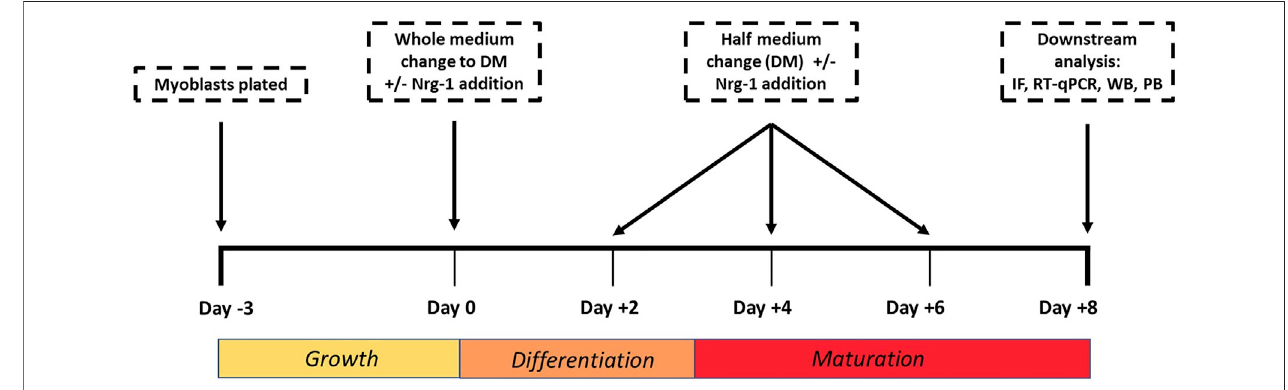
FIGURE 1 | Cell culture experimental timeline used to tissue engineer intrafusal skeletal muscle fi bres for downstream analysis. IF (Immuno fl uorescence microscopy), RT- qPCR (Reverse Transcription Quantitative Polymerase Chain Reaction), WB (Western Blot), PB (PrestoBlue).